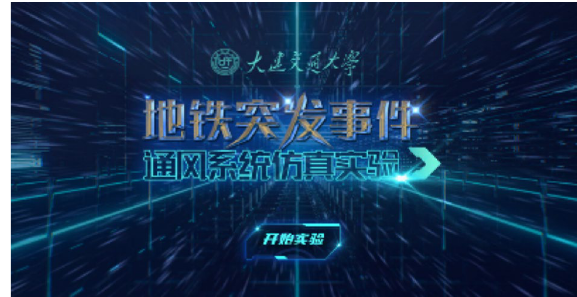
Figure 2. System main page.